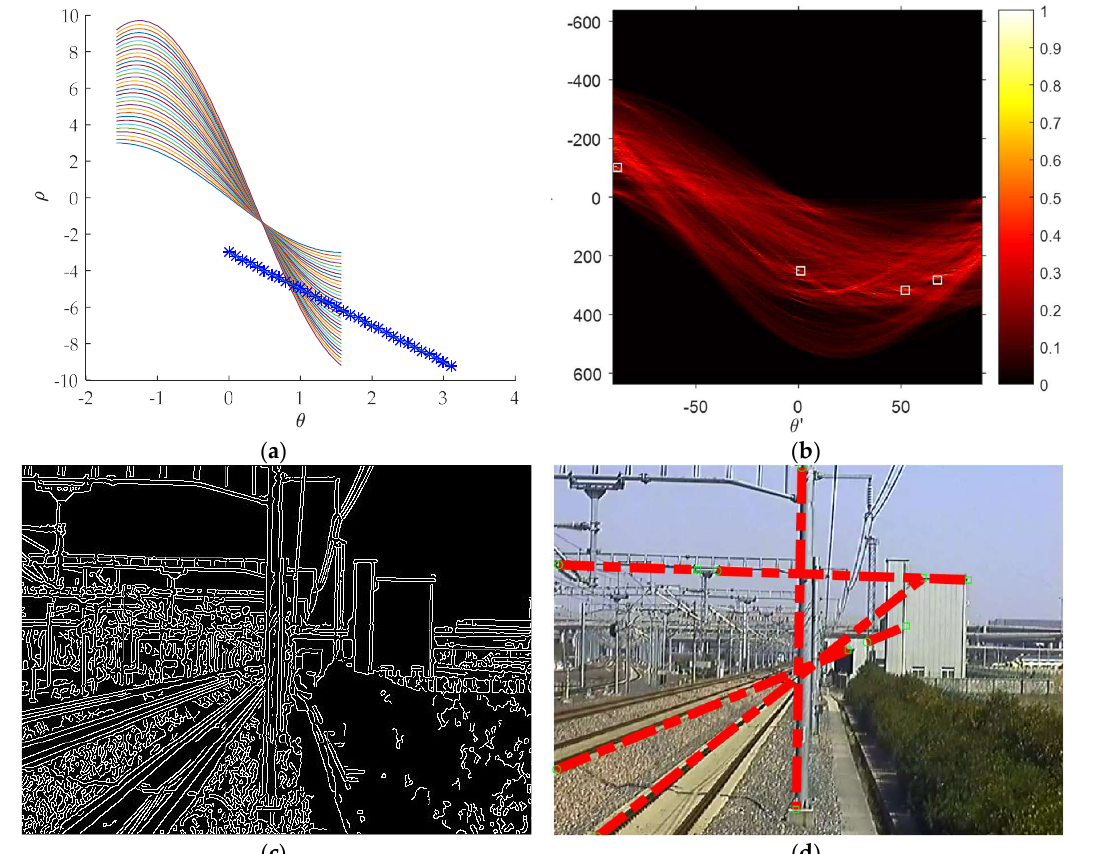
Figure 4. Using Hough transformation to detect the most significant lines in the Hough coordinate system. ( a ) The intersection point of a group of curves in the Hough coordinate system means there are a group of collinear points in the Cartesian coordinate system. ( b ) The more the curves intersect in the Hough coordinate system, the lighter the intersection point is, meaning that there are more collinear points along this line in the Cartesian coordinate system. ( c ) The texture feature maps filtered by canny filter. ( d ) The top four significant lines.